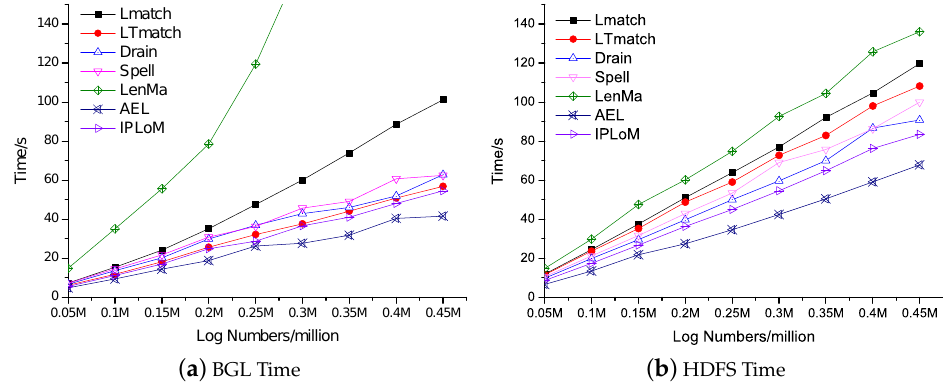
Figure 5. Time of different log parsers over different sizes of GBL/HDFS log data